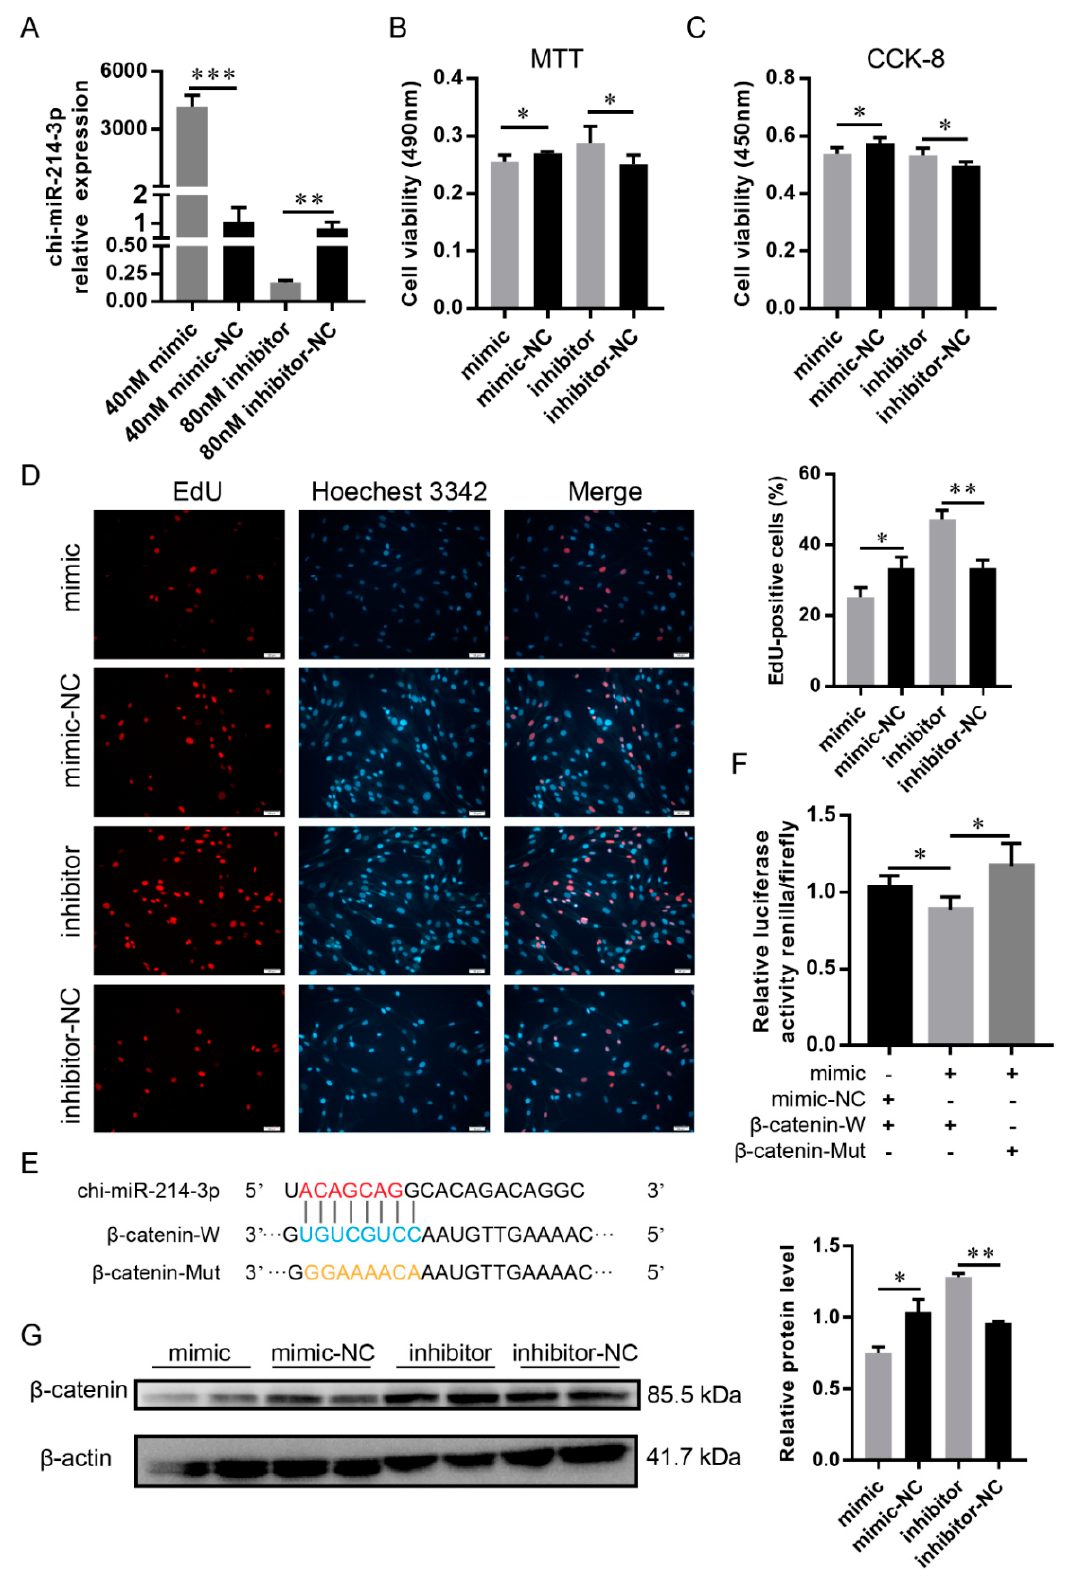
Figure 4. Chi-miR-214-3p targeted β -catenin and inhibited dermal papilla cells proliferation. ( A ) RT- qPCR detected the effect of chi-miR-214-3p mimic and inhibitor. ( B ) MTT analysis of dermal papilla cell proliferation. ( C ) CCK-8 analysis of dermal papilla cell proliferation. ( D ) EdU analysis of dermal papilla cell proliferation; the scale bar stands for 50 μ m. Red represents EdU staining and blue